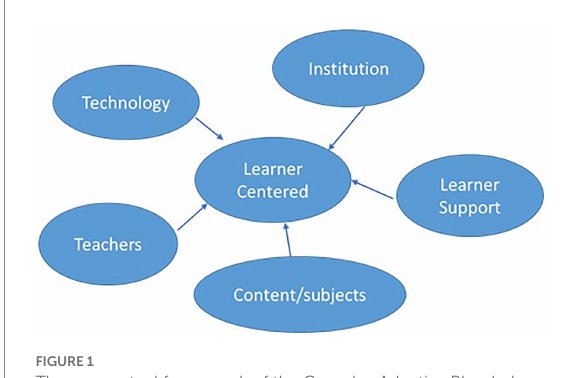
FIGURE 1 The conceptual framework of the Complex Adaptive Blended Learning System approach, which points to the learner-centered philosophy (Wang et al.,